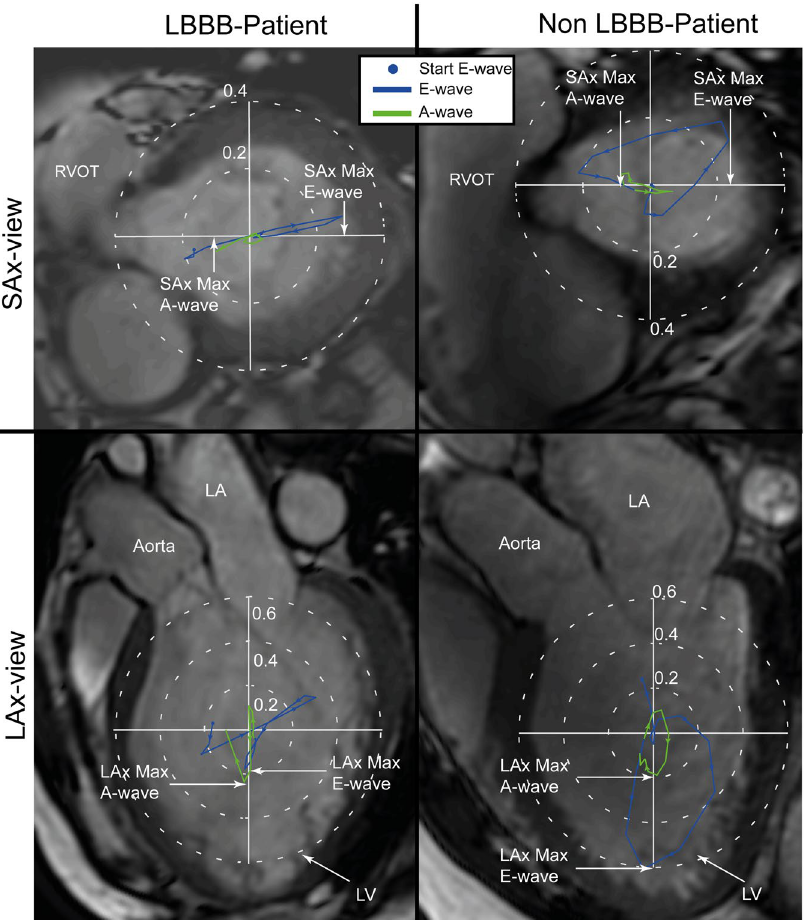
Figure 5. Hemodynamic forces [N] in a LBBB patient (left panels) and in a non-LBBB patient (right panels) projected onto a SAx-image (top) and LAx-image (bottom). The hemodynamic force plots are colored according to diastolic phases, E-wave (blue) and A-wave (green). The “SAx-max force/LAx-max force”-ratio was defined as the ratio between the maximum force along the anteroseptal-to-inferolateral axis in the SAx-view and the maximum force along the apex-to-base axis in the LAx three-chamber view. E-wave, early diastolic filling; A-wave, late diastolic filling; LA, left atrium; LV, left